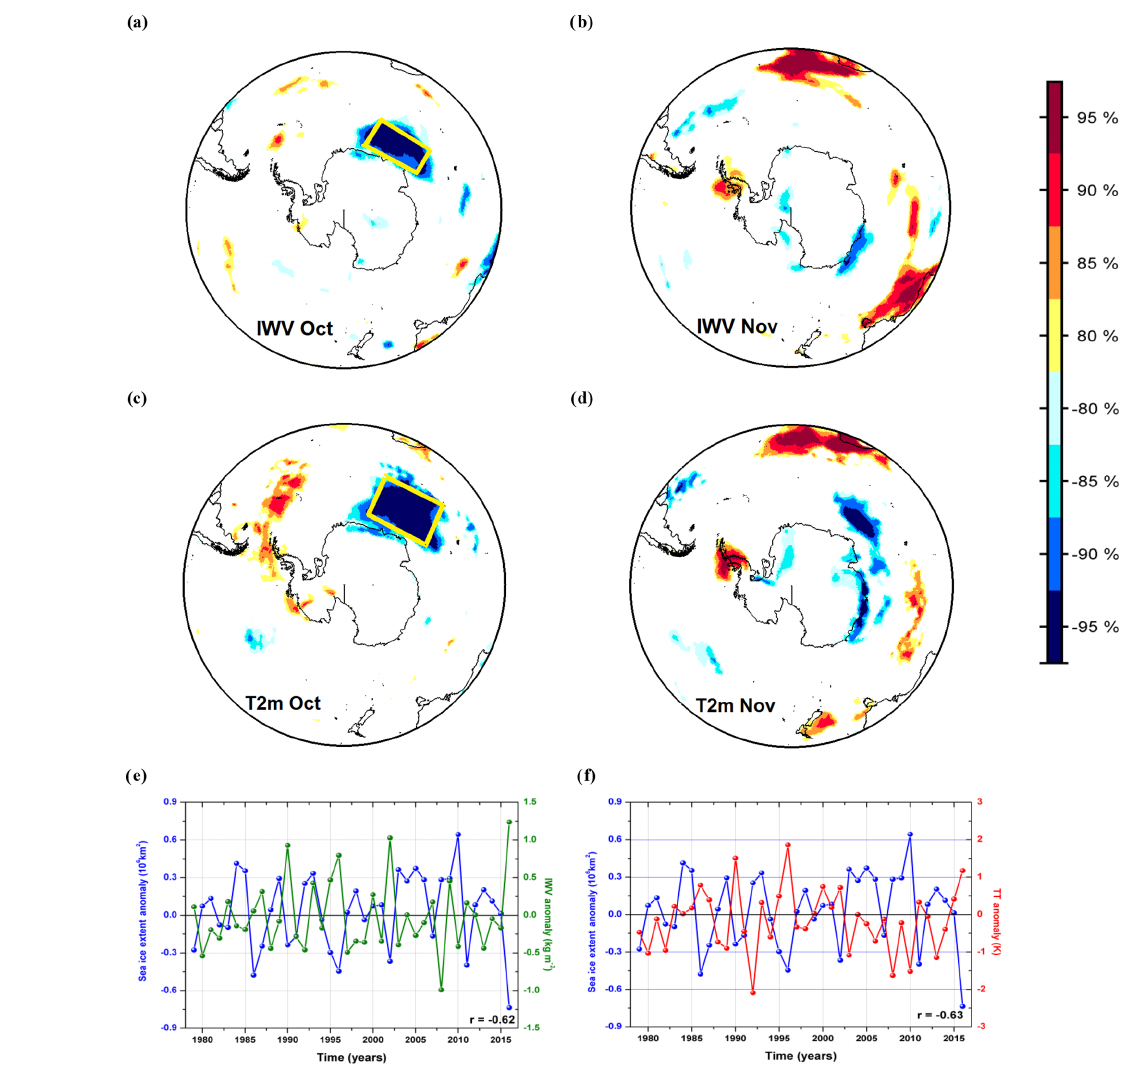
Figure 7. The stability maps between November Indian Ocean (IO) sea ice extent and (a) October IWV, (b) November IWV, (c) October T2m, and (d) November T2m. (e) The time series of November IO SIE (blue line) and the time series of October IWV (green line) averaged over the yellow box in (a) ; (f) the time series of November IO SIE (blue line) and the time series of October T2m (red line) averaged over the region shown in the yellow box in (c) . The regions where the correlation is positive and stable are represented as dark red (95% significance level), red (90 % significance level), orange (85% significance level), and yellow (80% significance level) and the regions where the correlation between the regional SIE index and the gridded data is stable and negative are represented as dark blue (95% significance level), blue (90% significance level), green (85% significance level), and light green (80% significance level) on the stability maps.